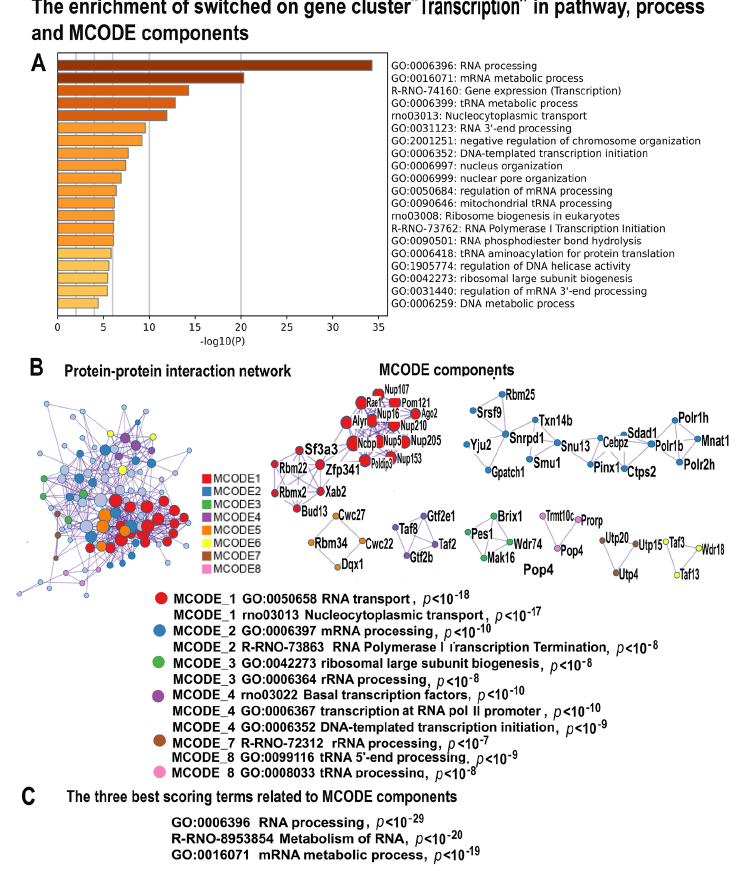
Figure 7. The enrichment of NLI − induced genes related to the cluster “Transcription” in gene pathway and process and in molecular complexes. ( A )—Bar graph of enriched terms related to gene pathways and processes across the gene cluster related to transcription. The statistical significance of enrichment is shown in X -axis ( − log10( p )). ( B )—Protein–protein interaction network and MCODE components (or densely connected network components) were identified in the gene list. The net- work and MCODE components were constructed on the base of physical interactions taken from the String server (physical score > 0.4). The coding by color square reflects the MCODE components. The coding by color circles indicates the results of the MCODE component pathway and process enrichment analysis. ( C )—The three best-scoring terms related to MCODE components.